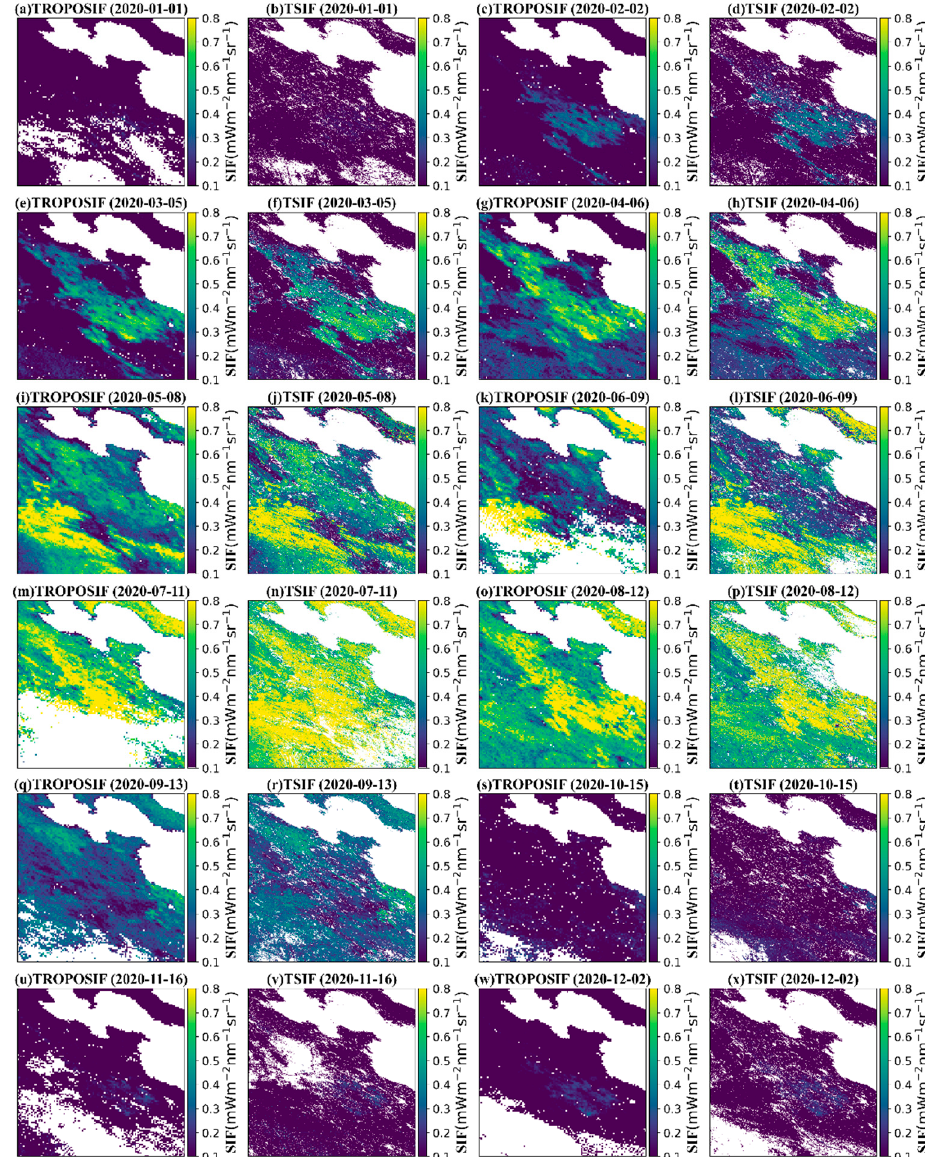
Figure 9. Spatial and temporal patterns of TSIF and TROPOSIF from January to December in 2020. White means no data due to pixel removal of water, barren and built-up, or cloud contamination ( a – x ).